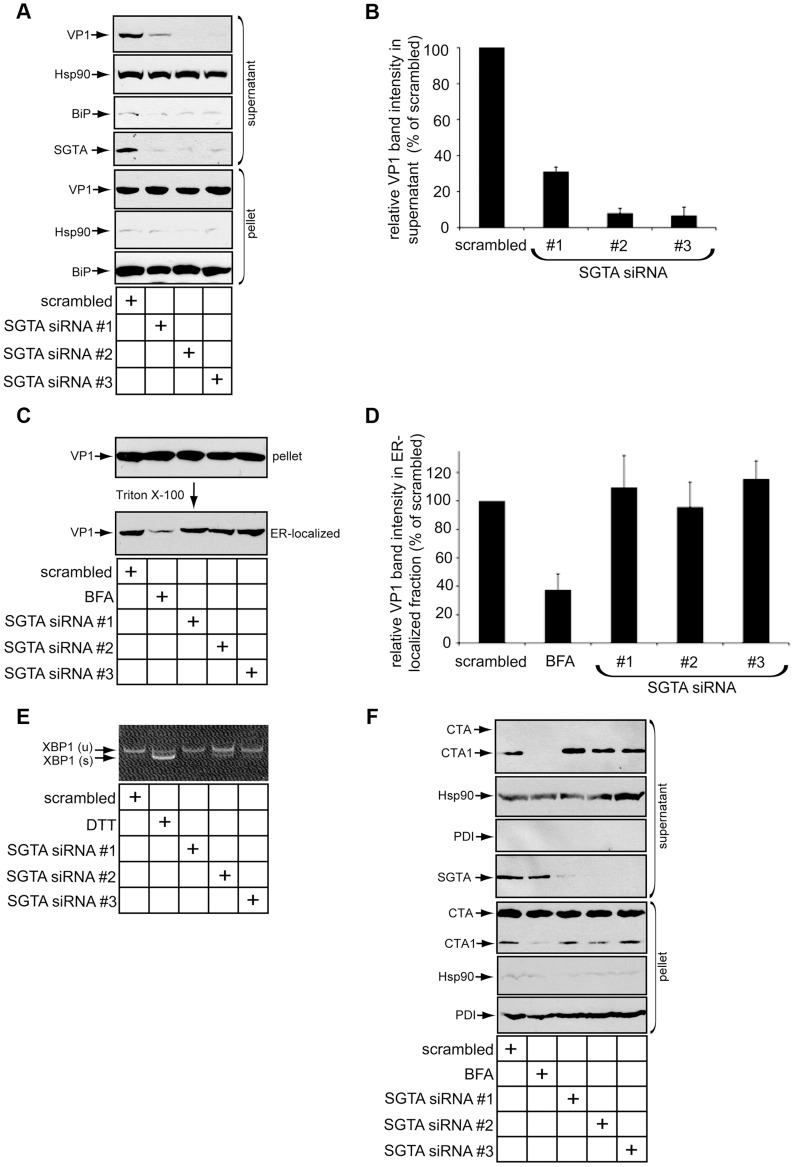
SGTA knockdown blocks viral ER-to-cytosol transport.(A) SGTA promotes ER-to-cytosol transport of SV40. CV-1 cells transfected for 24 h with the indicated siRNAs were incubated with SV40 at a MOI ≈5, harvested 12 h.p.i. and subjected to ER-to-cytosol transport assay (see experimental procedures). BiP and Hsp90 serve as markers for the ER and cytosol, respectively. (B) Relative VP1 band intensities in the supernatant fractions from (A) were determined using ImageJ. Data are normalized to scrambled siRNA. Values represent the mean ± SD of three independent experiments. A statistically significant (p<0.05) difference was observed with all SGTA knockdown conditions compared to scrambled. (C) Loss of SGTA does not block ER arrival of SV40. Pellet fraction produced from cells as in (A) were solubilized in a buffer containing 1% Triton X-100. After centrifugation, the soluble fractions were analyzed by VP1 immunoblotting. As a positive control, where indicated, cells were treated with BFA to block ER arrival. (D) Relative VP1 band intensities in Triton X-100 soluble (ER-localized) fractions from (C) were determined using ImageJ. Data are normalized to scrambled siRNA. Values represent the mean ± SD of three independent experiments. A statistically significant (p<0.05) difference was not observed with any SGTA knockdown conditions compared to scrambled. (E) XBP1 splicing does not occur with transient SGTA knockdown. RT-PCR analysis of the unspliced (u) and spliced (s) forms of XBP1 mRNA in cells transfected with scrambled or SGTA siRNAs. Where indicated, cells were treated with DTT as a positive control for ER stress induction. (F) CTA1 retro-translocation is not blocked by SGTA knockdown. CV-1 cells were transfected with the indicated siRNAs for 36–40 h before CT intoxication at 10 nM for 90 mins. Cells were harvested and fractionated as in (A). PDI and Hsp90 serve as markers for the ER and cytosol, respectively. A shorter exposure of CTA is provided for the pellet fraction to clearly display input toxin.